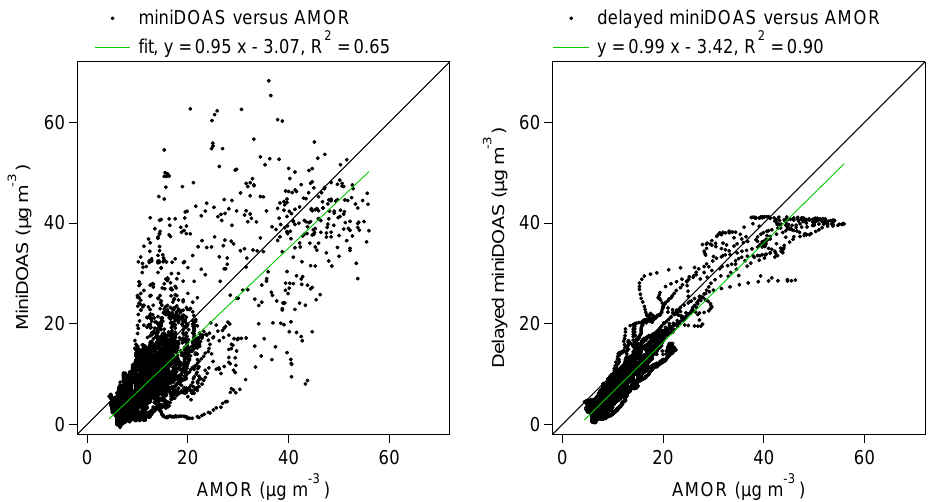
Fig. 20. Scatter plots of the minute values of the AMOR versus those of the miniDOAS (left panel) and of the minute values of the AMOR versus the delayed and smoothed miniDOAS data (right panel). Linear fits are indicated in green, the y = x curve is plotted as a black line.